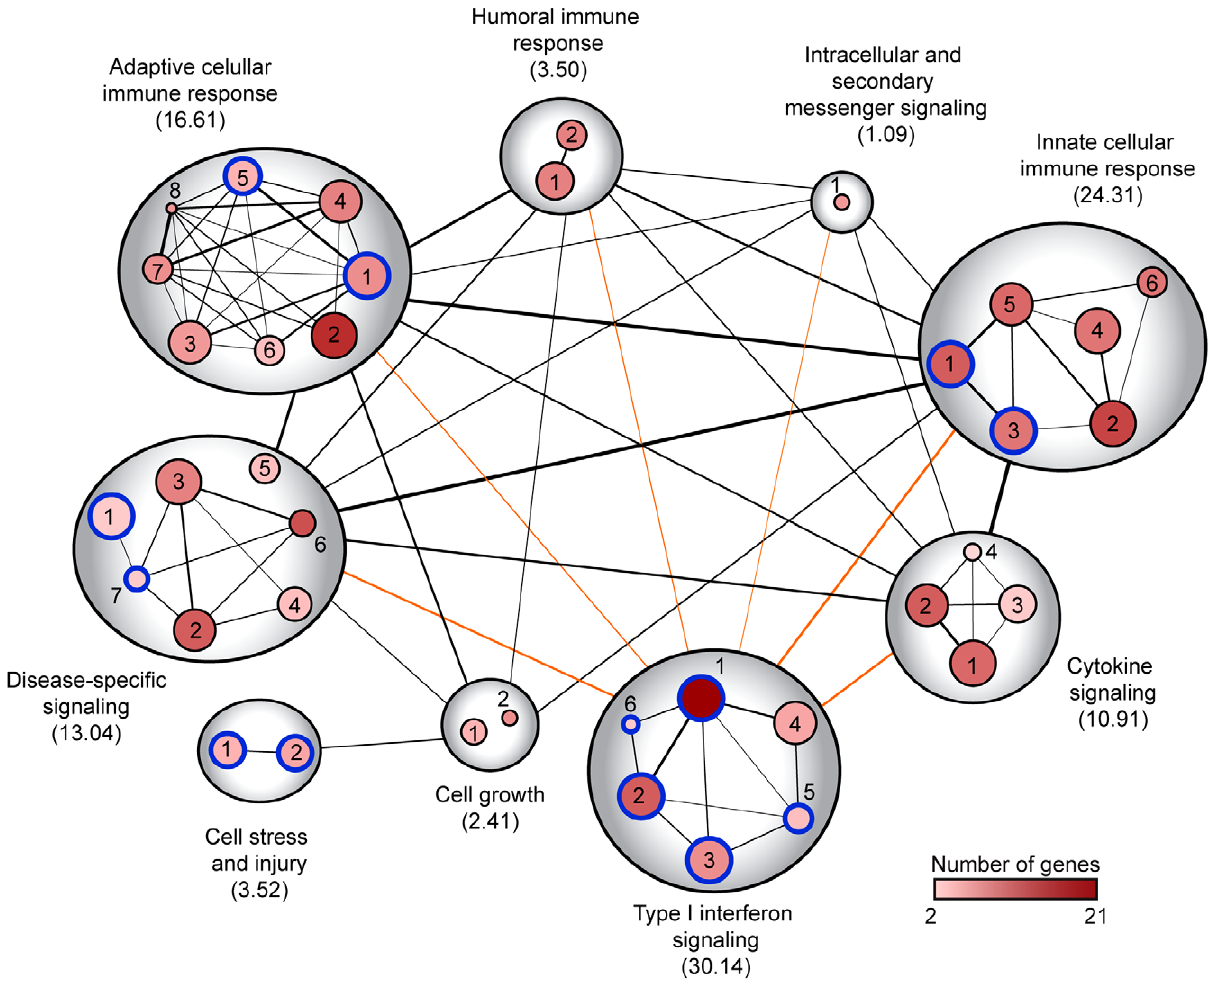
Figure 5. Network enrichment map of wild type WNV infected livers. Enrichment map for gene expression in WT infected livers. Nodes represent top scoring Ingenuity Pathway Analysis curated canonical pathway gene sets significantly enriched over mock-infected mice, and edges between nodes represent overlap between two connected gene sets. Edge thickness is proportional to number of overlapping genes. Node size is proportional to enrichment significance (the larger the node the greater the significance). Node color is proportional to the number of genes comprising the canonical pathway (the darker the node means greater number of genes). Node edges in blue represent common pathways between spleen and liver infected tissues. Nodes edges in black represent liver-specific pathways. Node identity is depicted by the number adjacent to each node and the key is listed in Table S4. Clusters were manually organized, circled, and labeled to highlight the prevalent biological functions among related gene sets. Enrichment scores ( 2 log 10 B-H P value) are depicted under the name of each biological function.